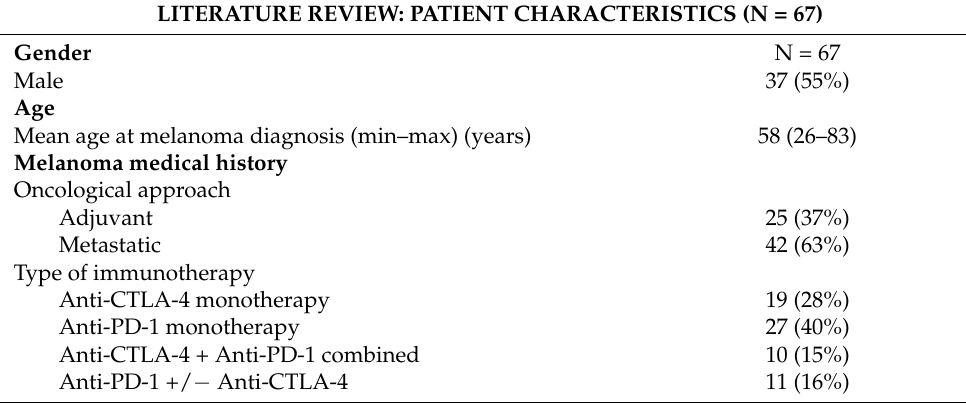
Figure 2. Kaplan Meier: OS and PFS estimates (median follow-up: 22 months). Table 2. Literature Review–Patient